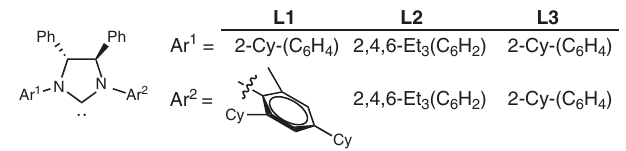
Fig. 1 General chiral insertions tactics for catalytic chiral allylic center preparations using 1,3-dienes. a Boration by chiral L-M-Bpin. b Hydro- silylation, -thiolation, and -boration. c Hydro-vinylation by (BDPP)CoCl 2 (1,4-insertion, exocyclic). d This work: hydroalkenylation by [chiral NHC – Ni (allyl)]BAr F .